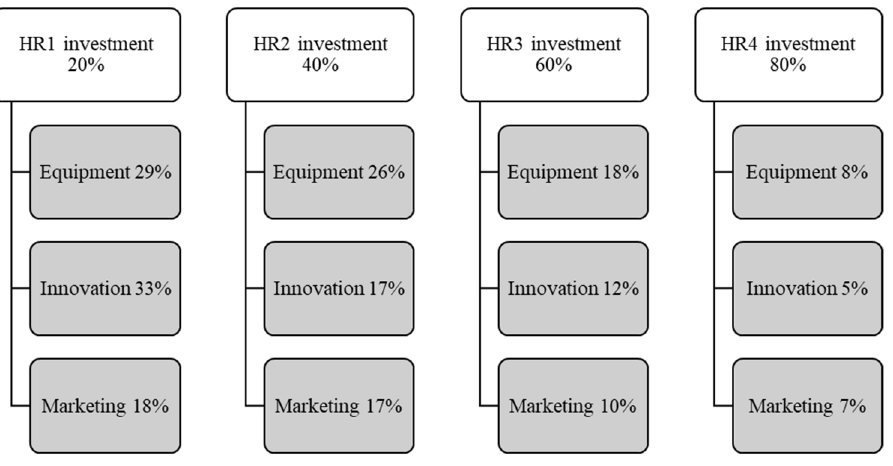
Figure 3. Investment portfolios according share on HR investment. Source: own processing.